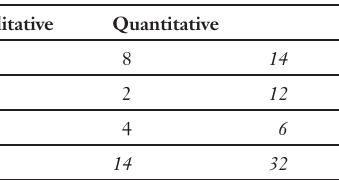
Distribution of included studies according to study design and